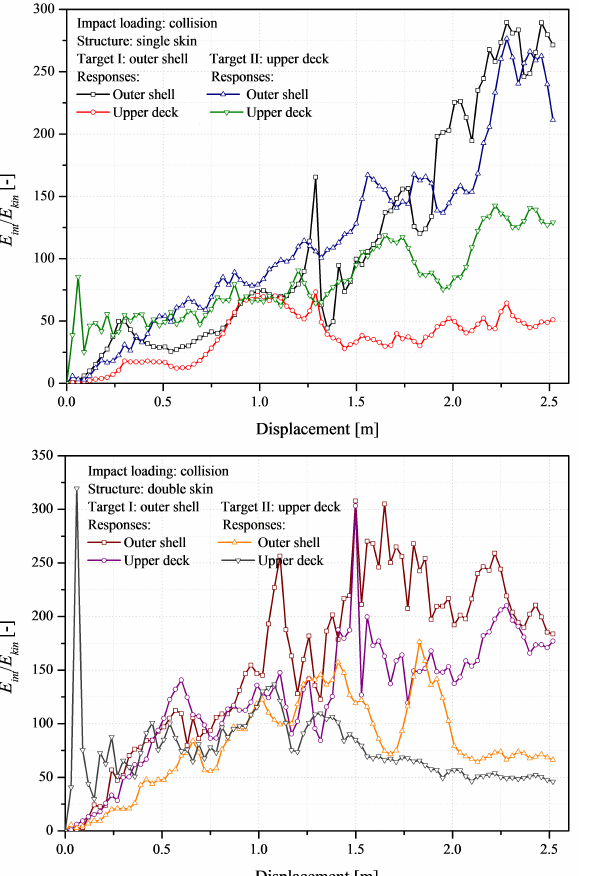
Figure 5: Summary of energy ratio for each impact target cluded that change in structural types is significantly af- fect amount of the absorbed energy with approximation 30%.